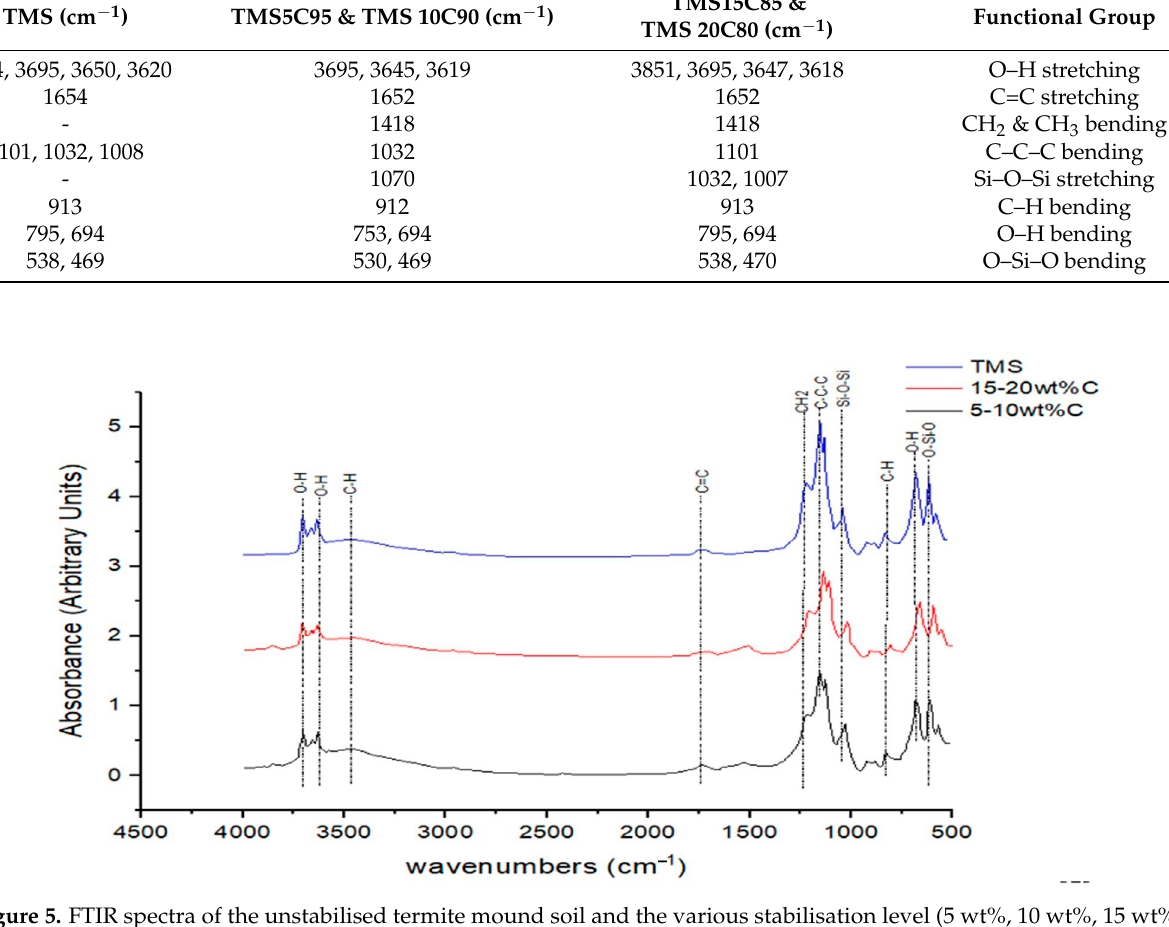
Figure 5. FTIR spectra of the unstabilised termite mound soil and the various stabilisation level (5 wt%, 10 wt%, 15 wt% and 20 wt%). Table 2. Peaks and functional groups present in the various samples. Termite mound soil (TMS),